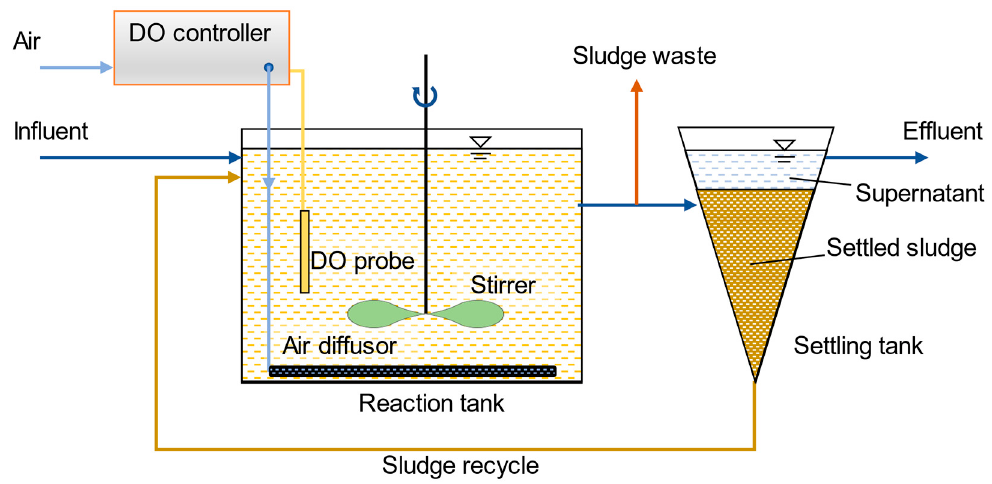
Figure 1. The schematic of the single-stage nitrite shunt denitrification bioreactor.